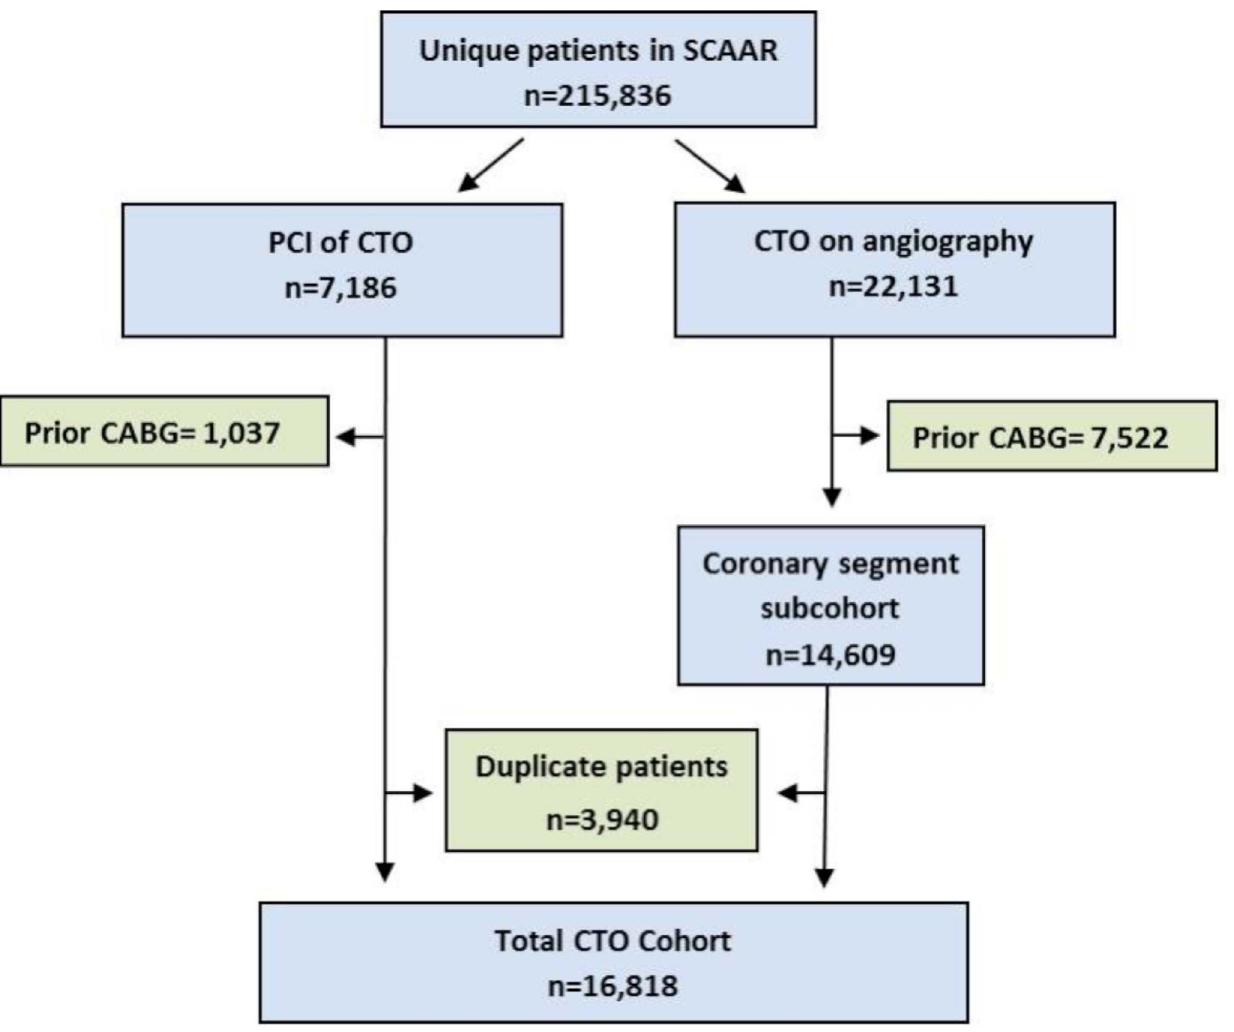
Figure 1. Flow chart for identification and selection of CTO patients in SCAAR. Based on the selection methods we have defined two CTO groups. The first group - the total CTO cohort- contains all CTO patients recognized by one or both methods during the period. The second group is the subcohort that contains the patients in whom a CTO was identified through the %-luminal stenosis on the coronary segments – the coronary segment subcohort .